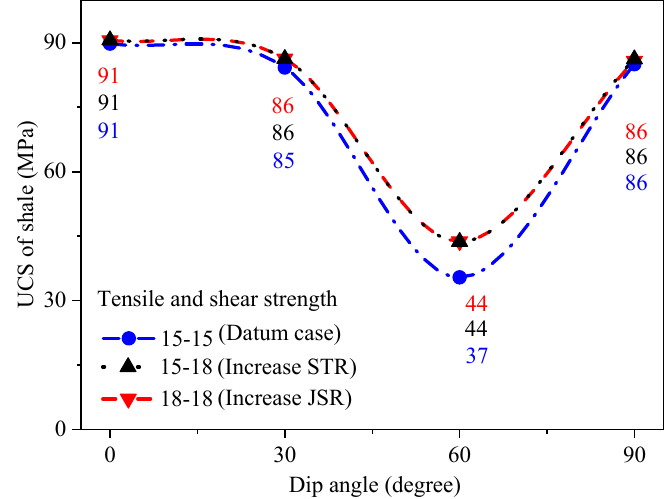
Figure 15. Variation of uniaxial compressive strength with dip angle at three bedding strength parameters.